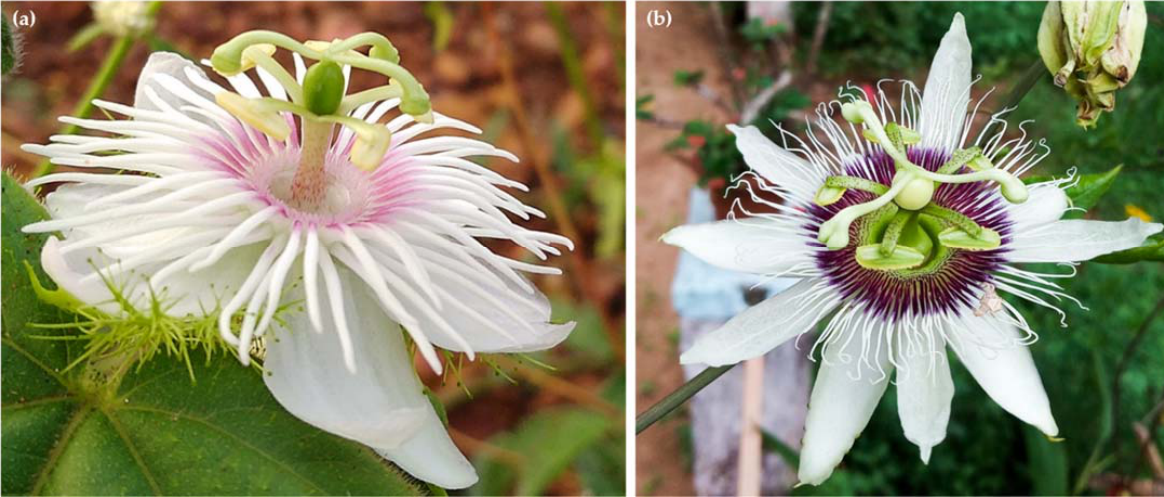
Figure 5. Difference in floral architecture between ( a ) P. foetida (wild) and ( b ) P. edulis